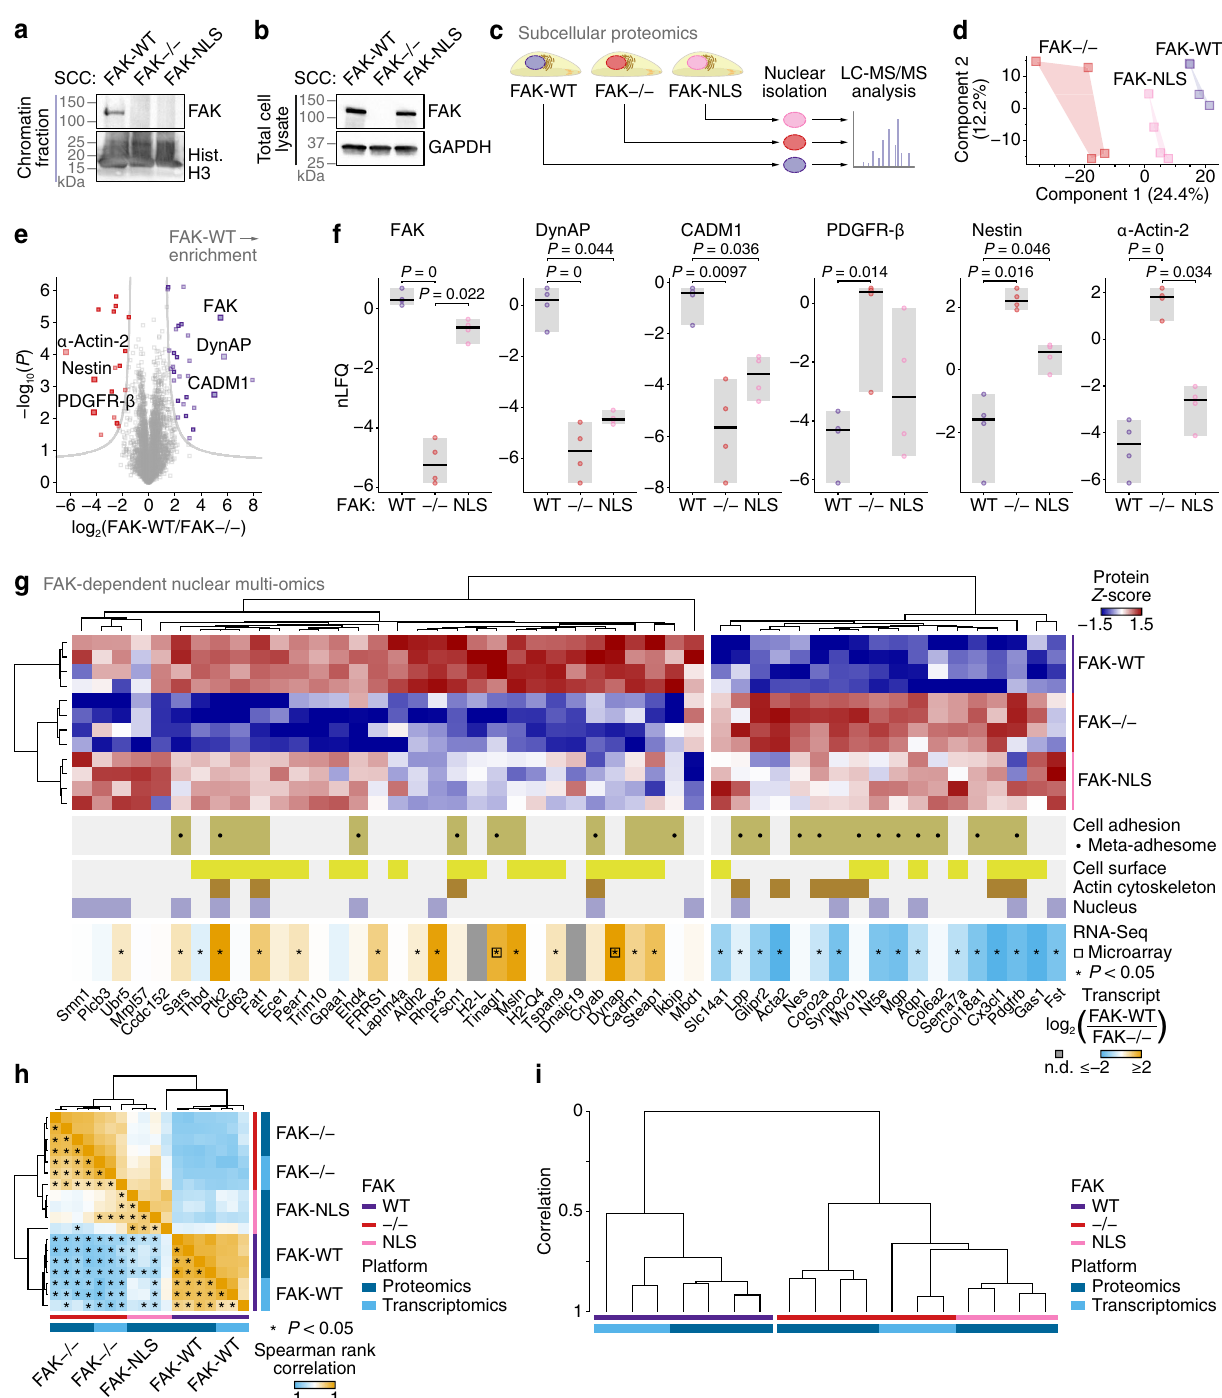
putative FAK-proximal nuclear proteins signi fi cantly enriched family member and nuclear-shuttling LIM domain-containing over control cells expressing unfused BirA * (an empty-vector consensus adhesome protein 61,62 (Fig. 5d, Supplementary Fig. 5a). Immuno fl uorescence con fi rmed that Hic-5 localises to negative control for nonspeci fi c interactions) ( P < 0.05, Student ’ s the nucleus (Fig. 5e), accumulating in the nucleus upon inhibition t -test with FDR correction) (Supplementary Data 10). Of these of exportin-1 using leptomycin B (Fig. 5e, f). nuclear proteins, several were adhesion-associated proteins, with To assess commonalities between FAK- and Hic-5-associated 9 (15.5%) in the consensus adhesome and 11 (19.0%) in the proteins in the nucleus, we examined the Hic-5-proximal nuclear literature-curated adhesome (Fig. 5b, c). Network analysis showed interactome using BioID (Supplementary Fig. 5b). Of the Hic-5- that FAK-proximal nuclear adhesion proteins formed a subnet- proximal nuclear proteins identi fi ed by LC-MS/MS analysis work of interacting proteins, which included the key FAK binding (Supplementary Data 11), a similar number to the FAK-proximal partner paxillin, which is also localised to the nucleus 48 (Fig. 2h) and contains LIM domains 18 , as well as Hic-5, another paxillin nuclear interactome were adhesion-associated proteins (12 NATURE COMMUNICATIONS| (2022) 13:3053